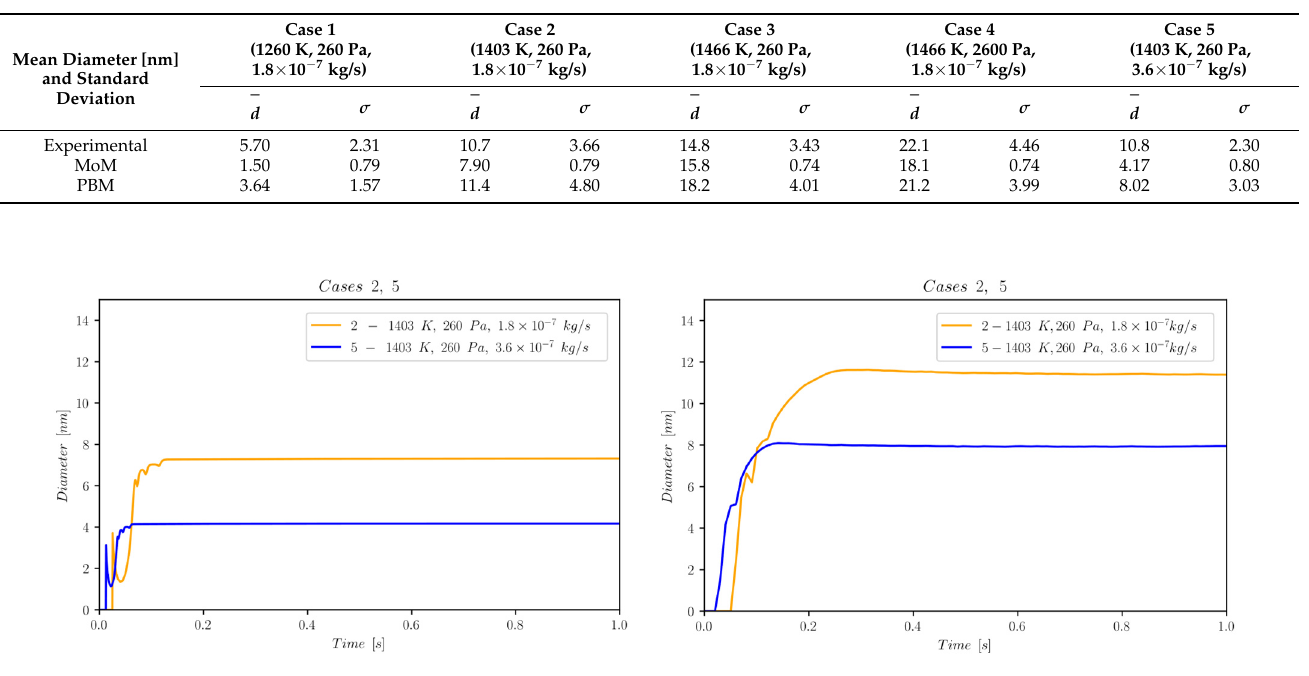
Figure 6. Temporal evolution of 𝑑̅ for cases 2 and 5, belonging to subclass ii (helium flow-dependence); ( left ) MoM, ( right ) PBM.